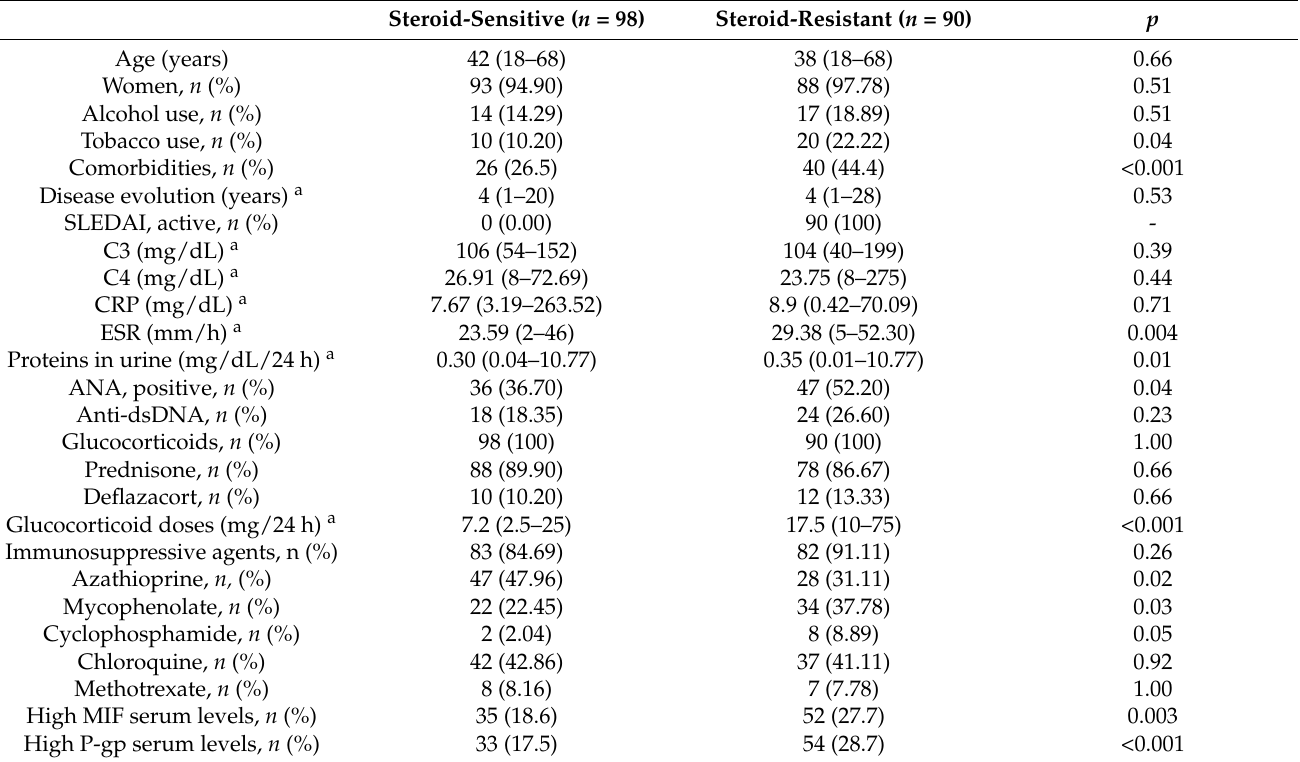
Table 3. Steroid-resistant and steroid-sensitive group